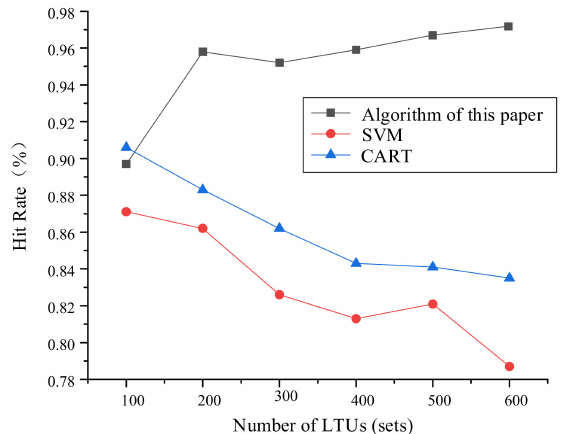
Figure 12. The overall accuracy of different algorithms under different LTU scales in a distribution Internet of